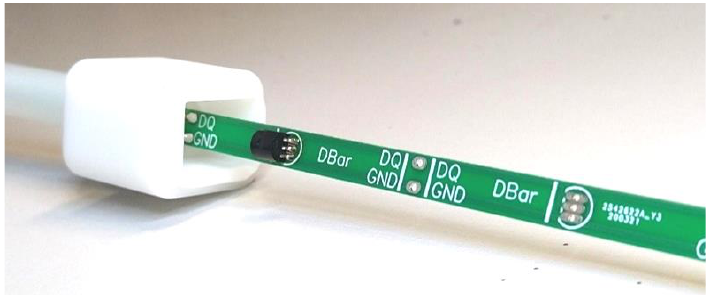
Figure 5. Sensors installed on a PCB module.